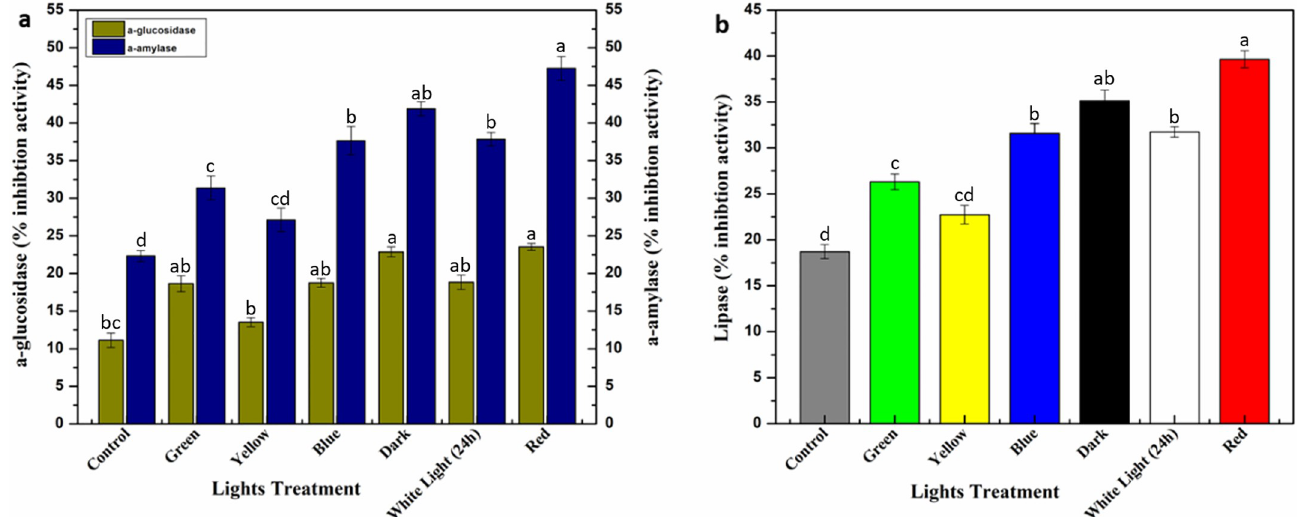
Fig 5. Differential effect of multispectral lights on a) Antidiabetic Activity (% inhibition) and b) Lipase Activity (% inhibition) in callus cultures of E . alba .